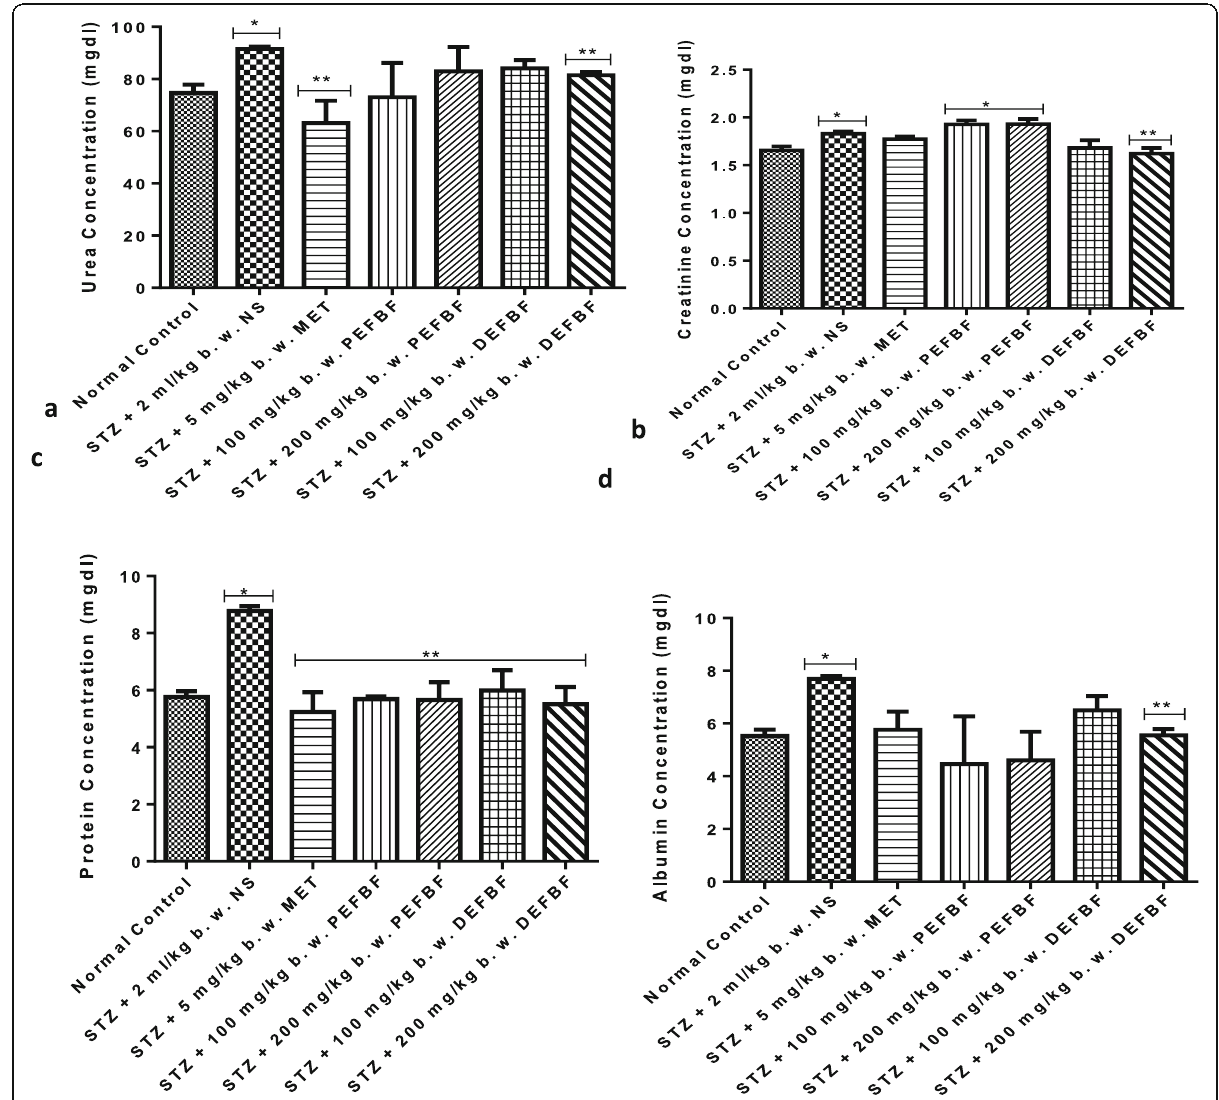
Fig. 4 ( a - d ): Results of the biochemical analysis of kidney function parameters of STZ induced Diabetic Rats treated with Fractions of Bridelia ferruginea Benth leaves. ( a ) Urea Concentration ( b ) Creatinin concentration ( c ) Total protein concentration ( d ) Albumin concentration. ** ( P <0.05) Significant compared to Normal control rats; * (P<0.05) significant compare with streptozotocin (STZ) induced rats administered 2ml/kg b. w. of normal saline. NS: Normal saline; MET: Metformin; PEFBF: Petroleum ether fraction of B. ferruginea ; DEFBF: diethyl ether fraction of B.